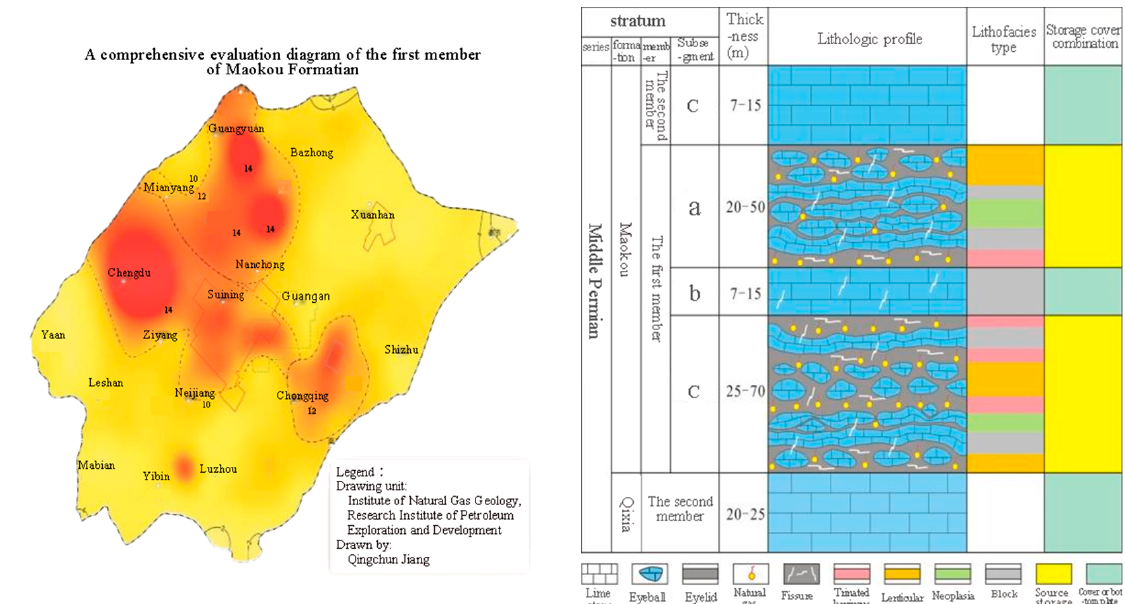
Figure 1. Overview of work area and reservoir cap combination.